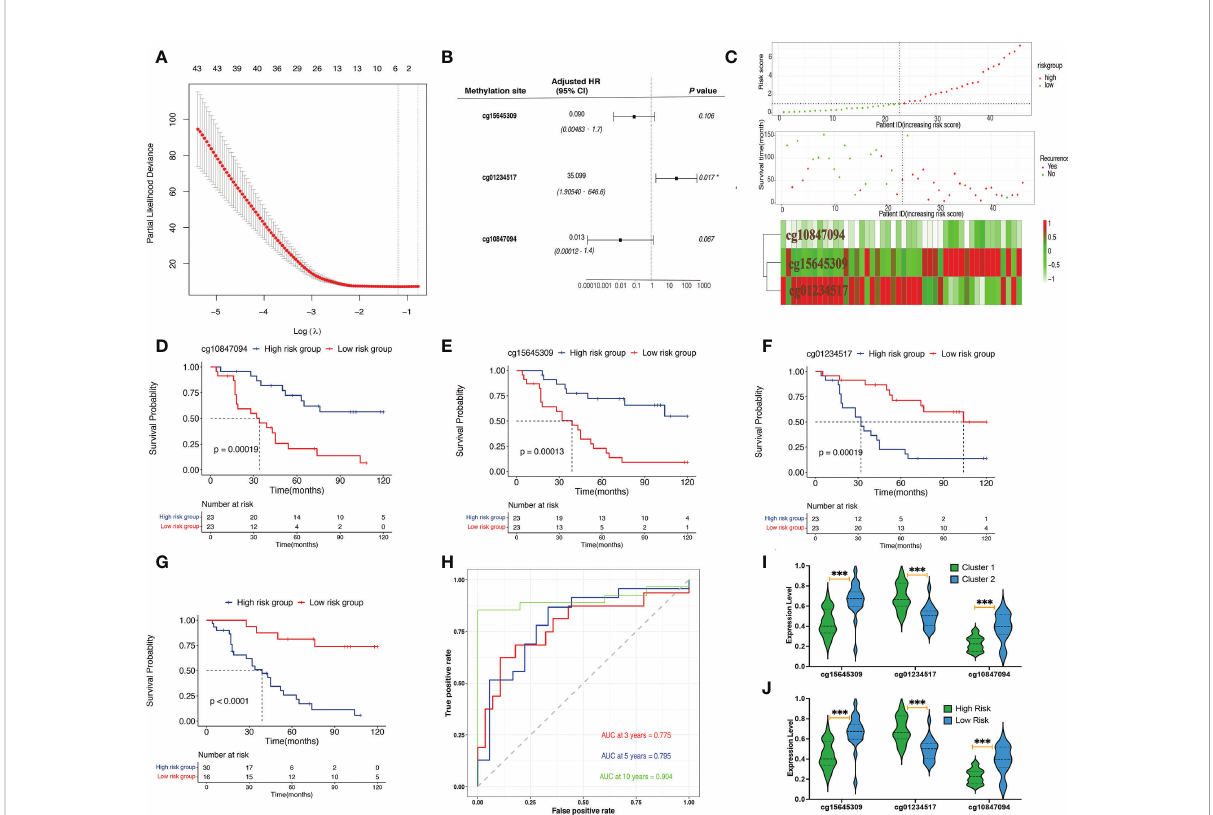
FIGURE 2 Identi fi cation and validation of prognostic signatures. (A) The LASSO process of developing a prognostic signature from 502 methylation sites. (B) The hazard ratio and the coef fi cients of the three methylation sites in the model calculated from multivariate Cox regression analysis. (C) The distribution of risk scores of 46 samples, the survival status of the 46 samples, and the heat map of the three methylation sites. (D) A Kaplan – Meier plot showing that the high-risk group had a signi fi cantly worse disease-speci fi c survival time than the low-risk group. (E – G) A Kaplan – Meier plot showing that the high cg15645309 and cg10847094 groups had signi fi cantly worse disease-speci fi c survival times than the low-expression group whereas the low cg01234517 group had a signi fi cantly worse disease-speci fi c survival time than the low-expression group. (H) Prognostic signature analysis showing the 3-, 5-, and 10-year area-under-the-curve values of 0.775, 0.795, and 0.904, respectively. (I) Violin plots of the beta values of the three methylation sites between cluster 1 and cluster 2 samples. (J) Violin plots of the beta values of the three methylation sites between high- risk and low-risk samples (*** p < 0.001, * p <